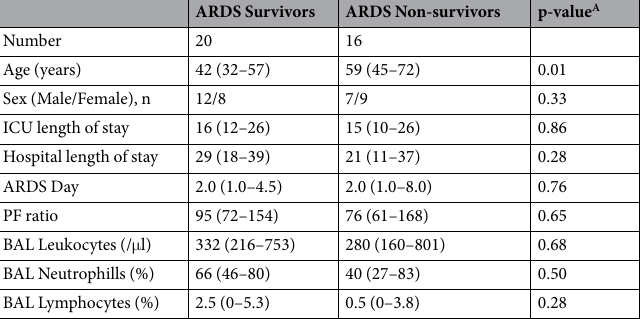
Table 2. Demographic and Clinical Characteristics of Study Subjects. Values are median (inter-quartile range), unless otherwise noted. A P-values are from the Mann-Whitney U test for comparing medians, except for sex which uses a Chi-square test on the percentage of male/female. BAL, Bronchoalveolar lavage; ICU, Intensive Care Unit; PF Ratio, PO 2 : FiO 2 ratio. ARDS day: the day BALF was obtained relative to ARDS onset as defined by mechanical ventilation initiation.